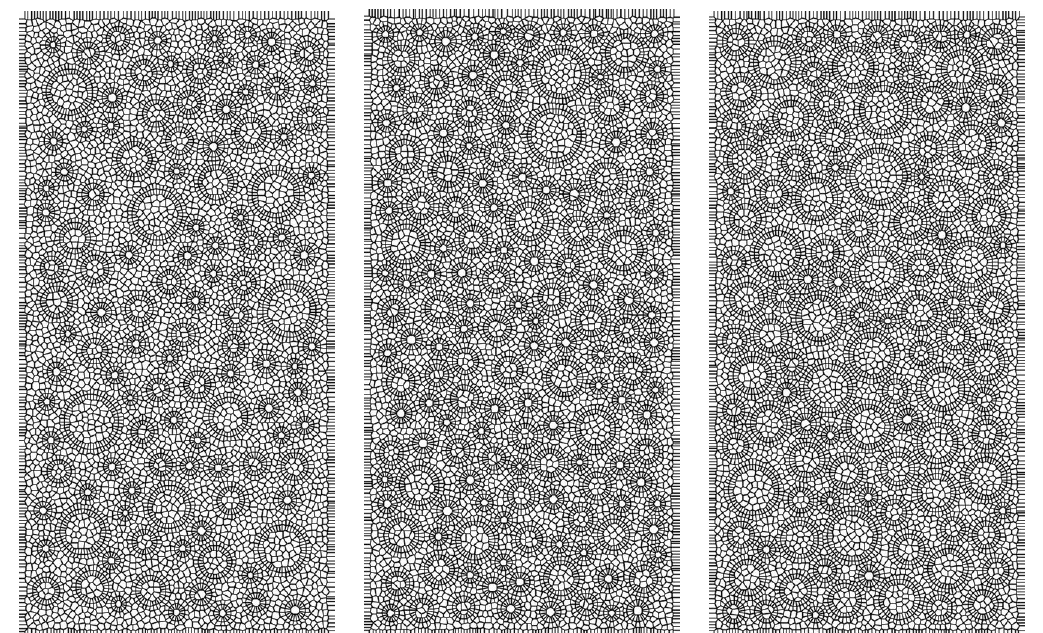
Fig. 7. Concrete samples with the aggregate volume fractions: f = 30% (F30), 40%(F40) and 50%(F50)